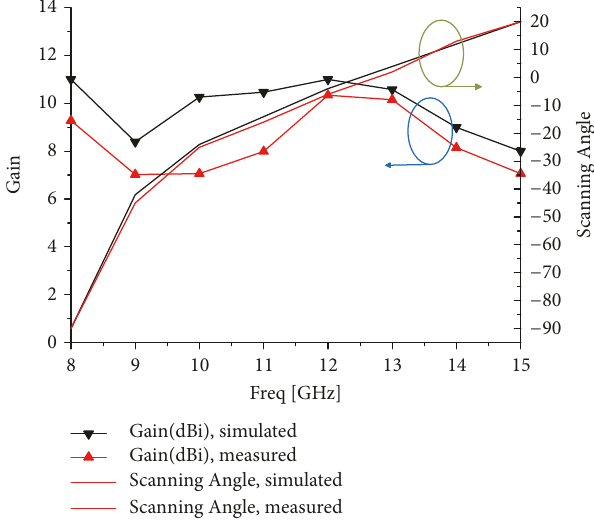
Figure 18: Gain and scanning angle of the proposed